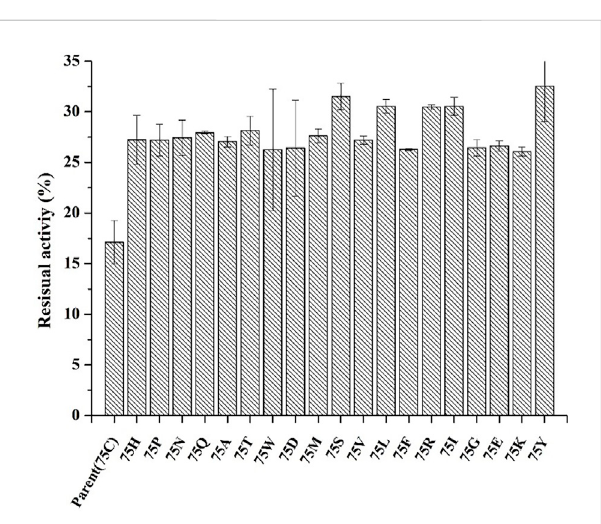
Theresidualenzymeactivityofmutantsaftersaturationmutation at position 75 of phytase. (incubating at 99 ° C for 30